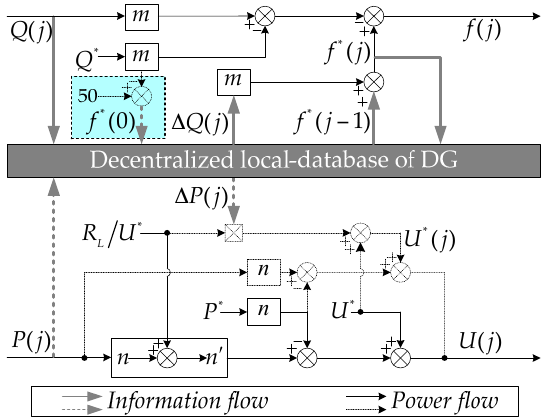
Figure 6. CFR/CVAR-based droop controller design.